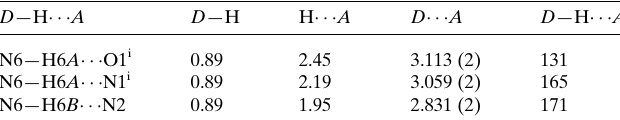
Table 1 Hydrogen-bond geometry (A˚ , (cid:4) ).